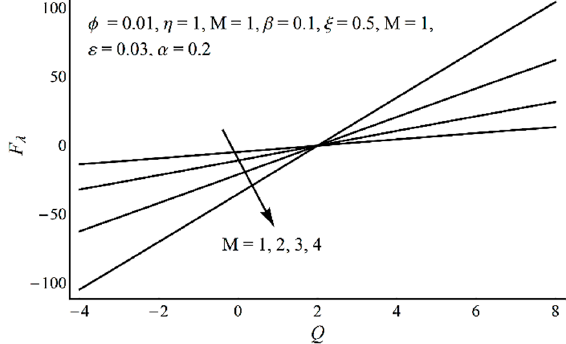
Figure 27. Variations of frictional forces for different values of M.